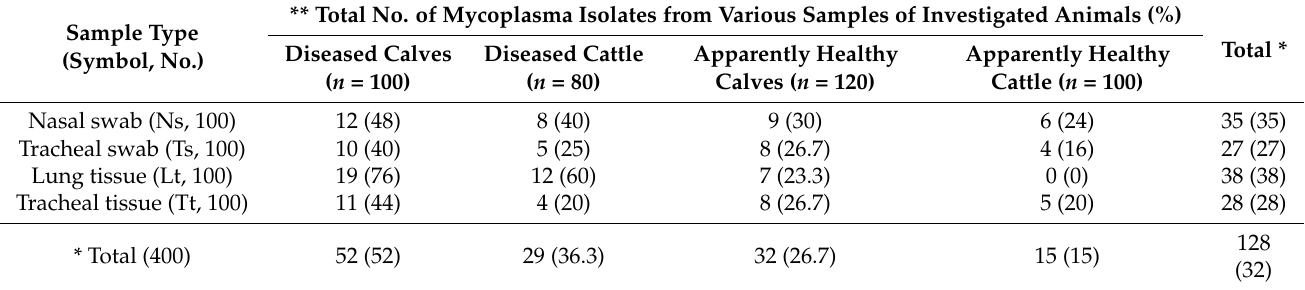
Table 4. Prevalence of bovine Mycoplasma species in various samples at Sharkia Governorate,